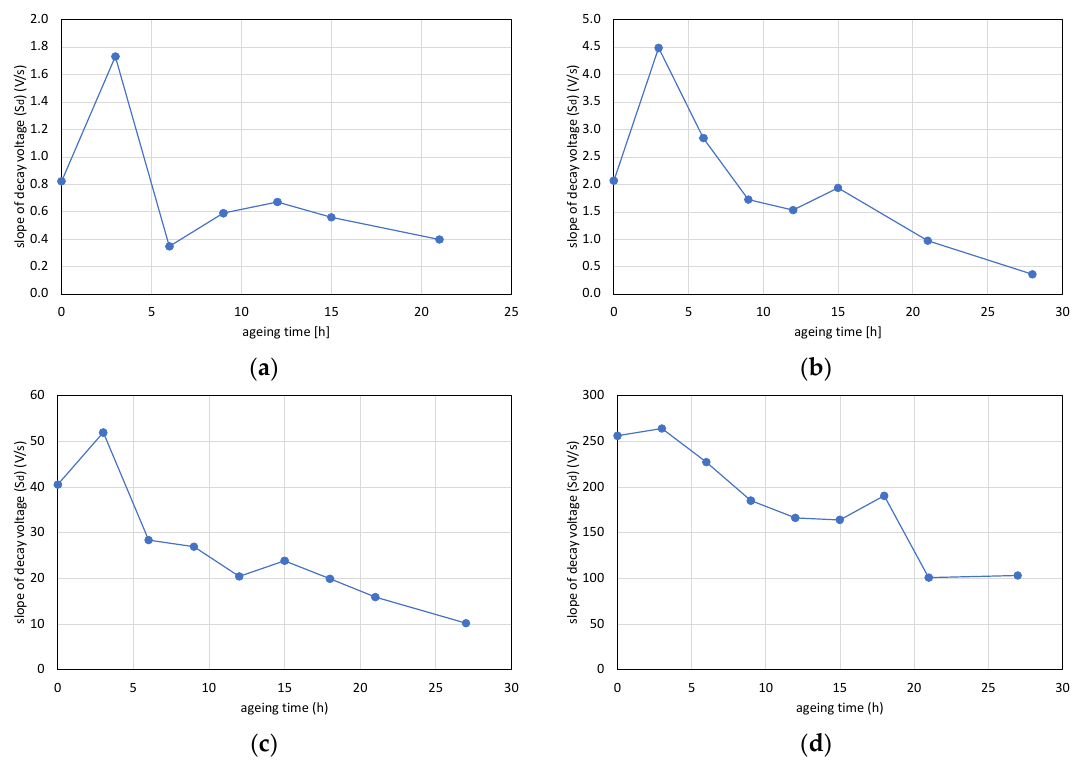
Figure 12. Changing of slopes of decay voltages with aging time of PVC films: ( a ) DOP0, ( b ) DOP30, ( c ) DOP40, and ( d ) DOP50.